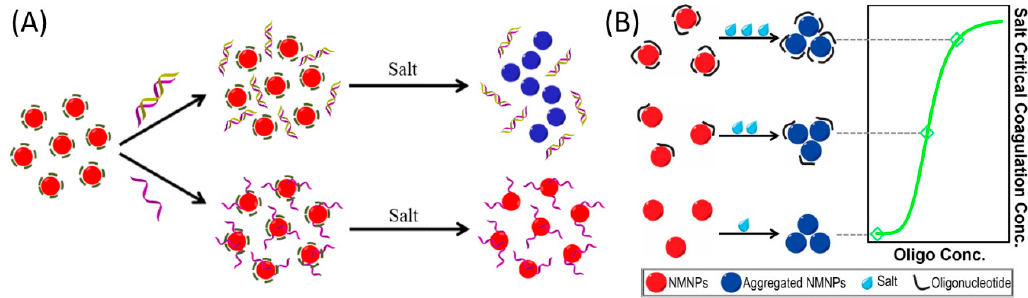
Figure 4. Schematic illustration of critical coagulation concentration based salt titration for visual quantification ( A ) AuNPs based colorimetric method for single strand and double DNA detection and ( B ) salt-titration based colorimetric method for determining the adsorption strength between NMNPs and oligonucleotides. Reprinted with permission from Journal of Laboratory Automation, 2014, 19,